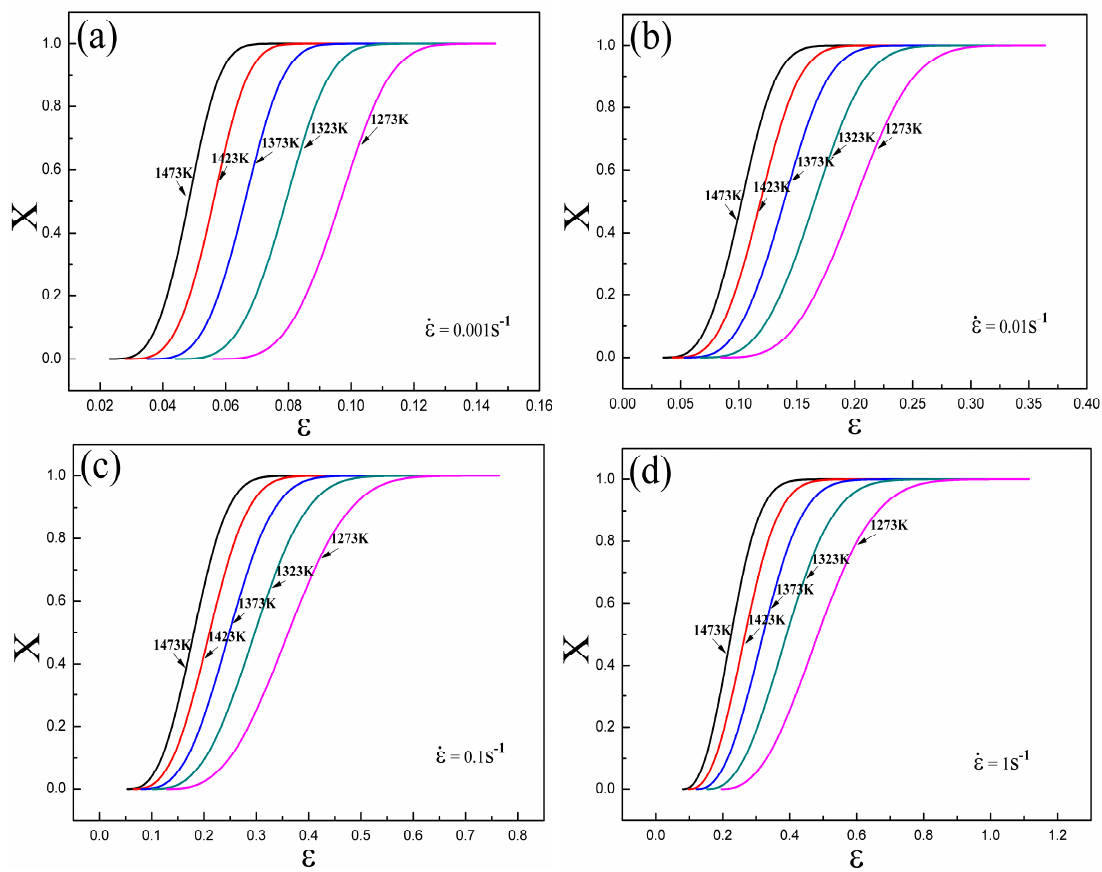
. ε  ε  ε = 0.001 s − 1 ; = 0.001 s -1 ; ( b ) = 0.01